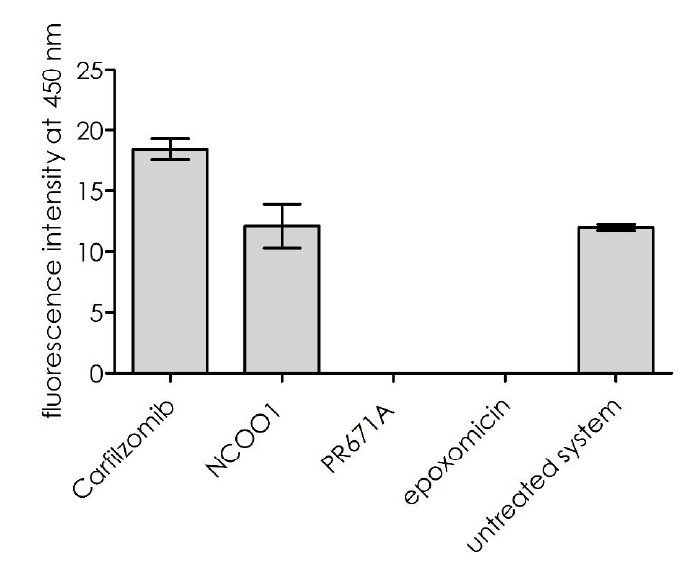
Figure5. 20Sproteasomeactivityinthepresenceofselectiveproteasomeinhibitors. Compounds Figure 5. 20S proteasome activity in the presence of selective proteasome inhibitors. Compounds used